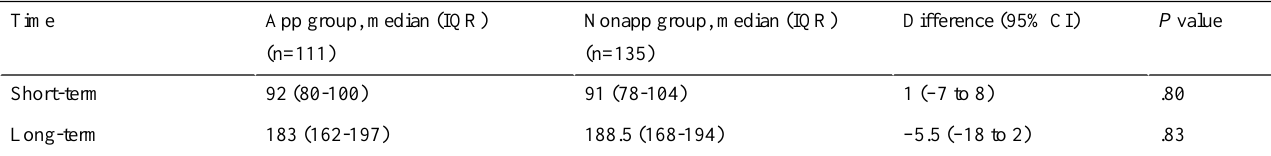
Table 3. Days from baseline for both short-term and long-term follow-up time periods. P values used a Wilcoxon test and 95% CIs were